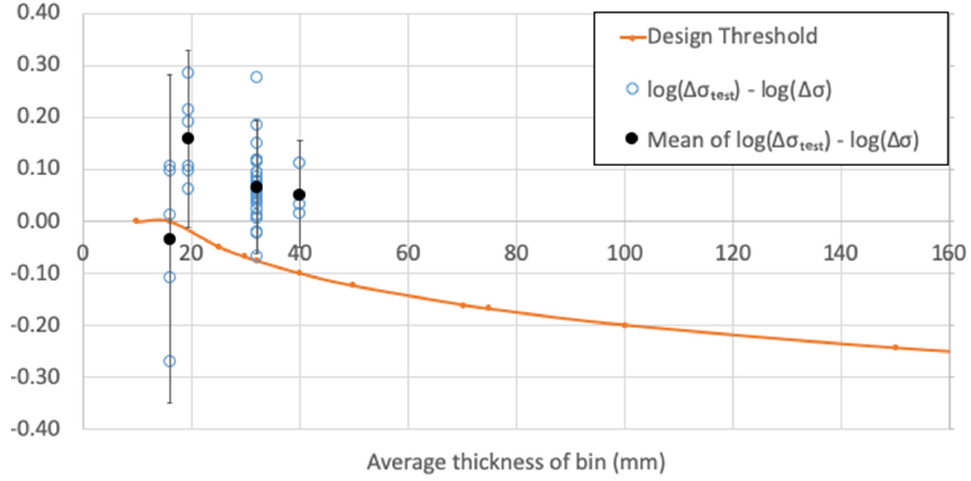
Figure 20. Data analysis of tubular joint with CP. Figure 22. Data analysis of tubular joint with CP .